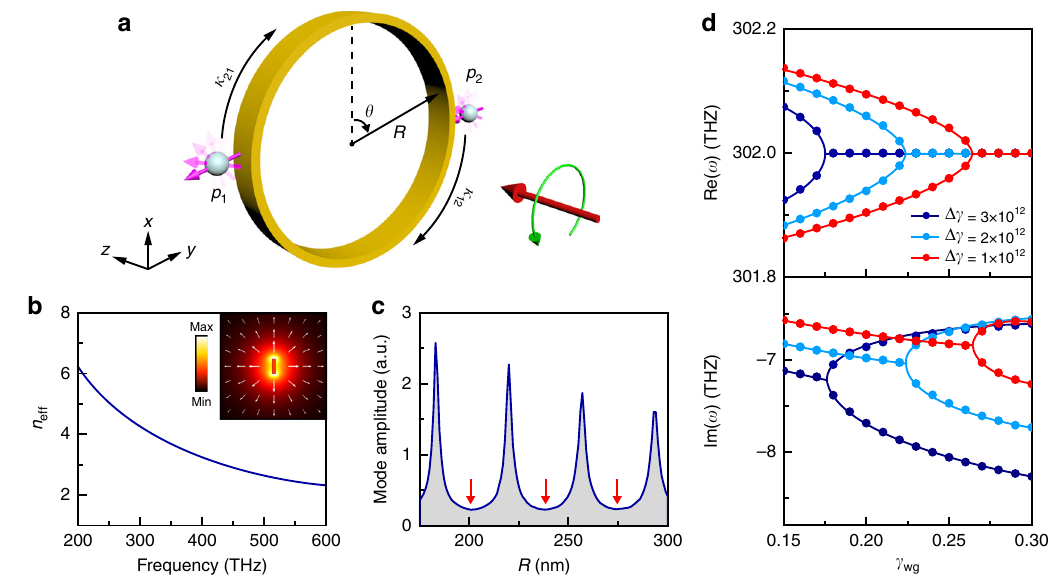
Fig. 1 Exceptional point in coupled-dipole-resonator model system with mutual coupling. a Two spherical dipole resonators ( p 1 , p 2 ) placed near a circular plasmonic waveguide. Their chiral dipole resonance modes couple with each other through the unidirectionally propagating plasmon under spin – momentum locking. b Effective mode index of the guided plasmon. The inset shows the magnitude (colour) and direction (arrows) of the mode electric fi eld. c Amplitude of the guided plasmon as a function of radius R under the excitation of a point source near the circular waveguide. The peaks correspond to constructive interferences of the plasmon and the dips (marked by the red arrows) correspond to destructive interferences. d Real and imaginary parts of the eigenfrequencies as a function of the loss γ wg of the lower-half waveguide ( θ ∈ [ π /2,3 π /2]) obtained by coupled mode theory. Δ γ is the loss difference of the two